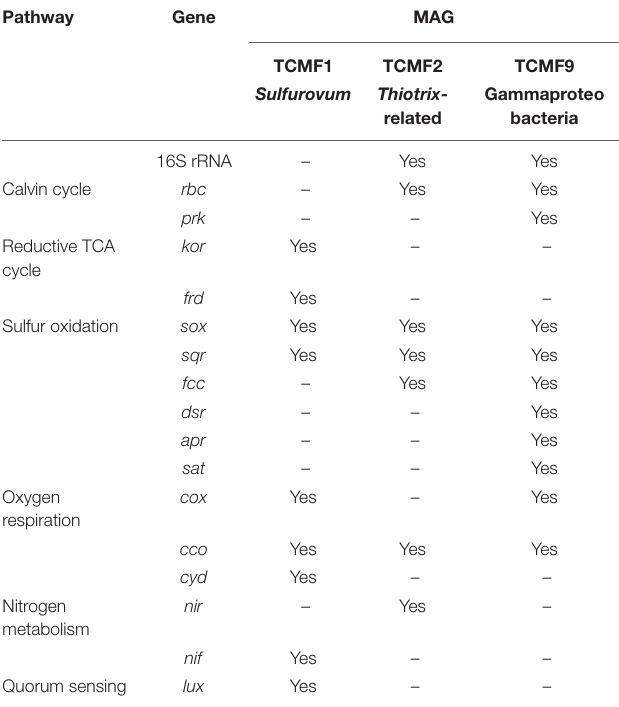
TABLE 1 | Genes involved in main metabolic pathways recovered from MAGs. Pathway